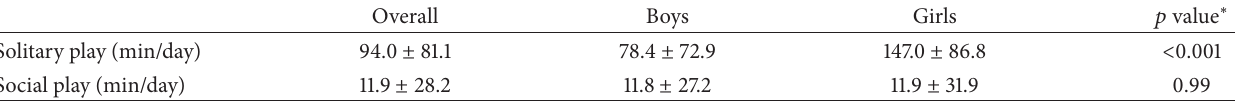
Table 2: Time spent in social or solitary play activities (Minutes) in children with ASD by gender